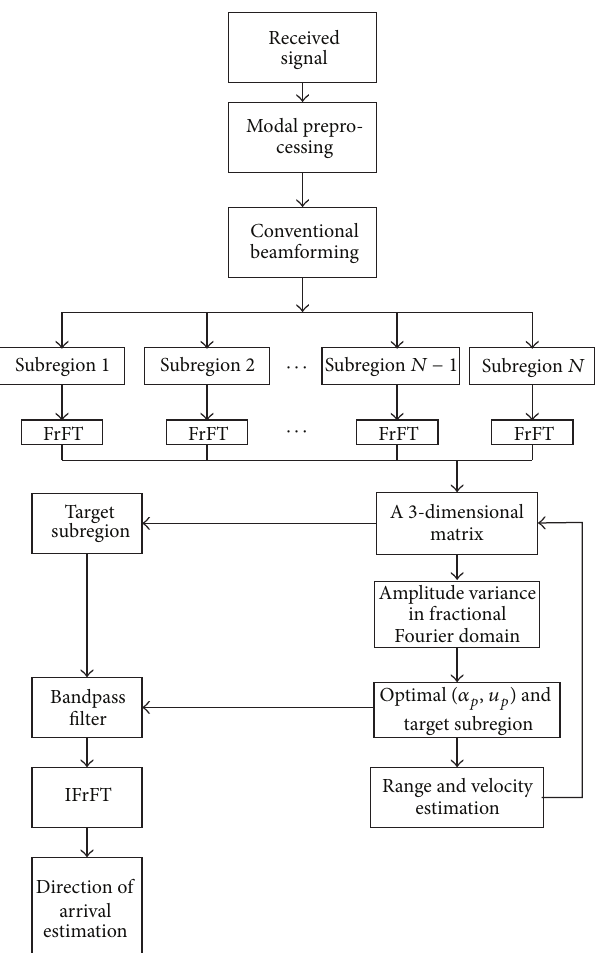
Figure 1: The block diagram of the proposed method for detection and parameters (range and direction of arrival) estimation of multiple moving